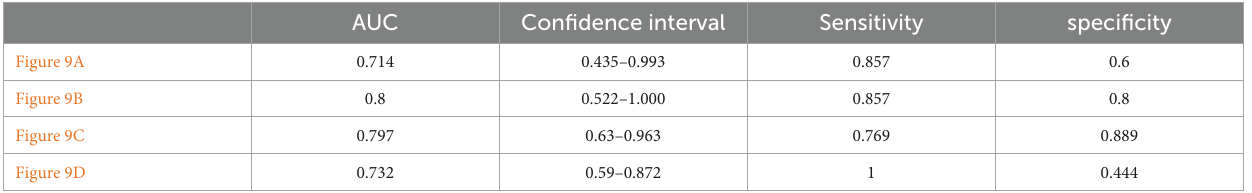
TABLE 7 Specific information of ROC